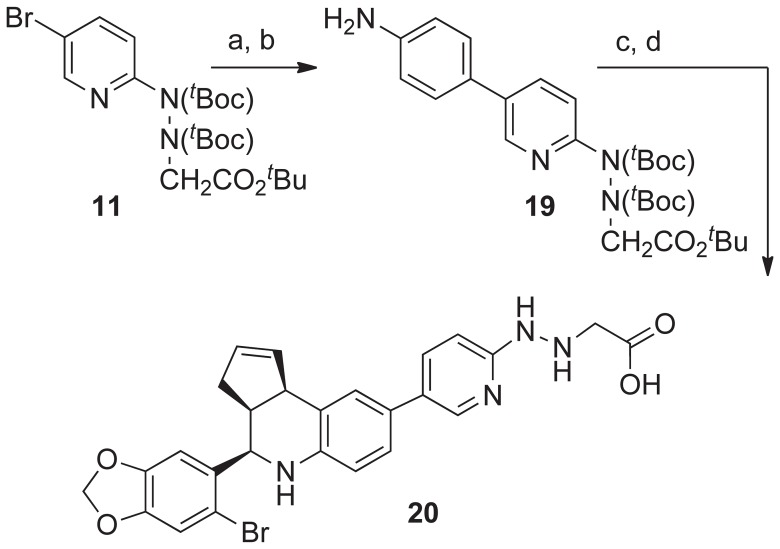
Synthesis of pyridin-2-yl-hydrazinylethanoic acid ligand 20.Reagents and conditions: a) 5, bispinacolatodiboron (1.5 eq), PdCl2dppf*CH2Cl2 (8 mol%), KOAc (5 eq), DMF, 80°C, 16 h, 94%; b) 4-iodoaniline (0.9 eq), KOH (2 eq), and Pd-catalyst (4 mol %) [29], MeOH/H2O (3∶1), 60°C, 3 h, 13 70%; c) 6-bromopiperonal (1 eq), Sc(OTf)3 (10 mol%), cyclopentadiene (5 eq), MeCN, rt, 4 h, 74%; d) TFA/DCM (0.8∶1.0), 45 min, 20, 90%.